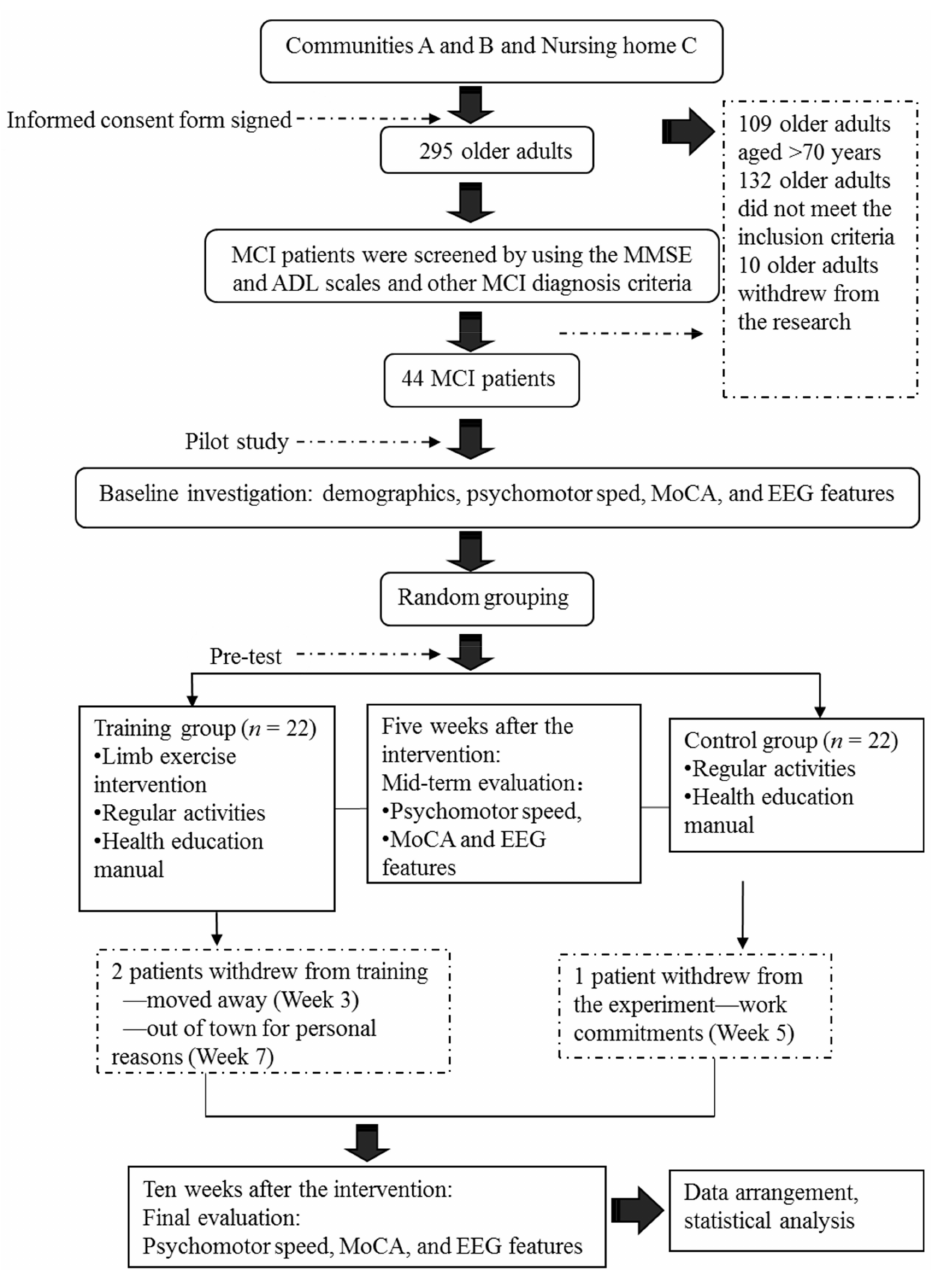
Figure 1. Flowchart of the research